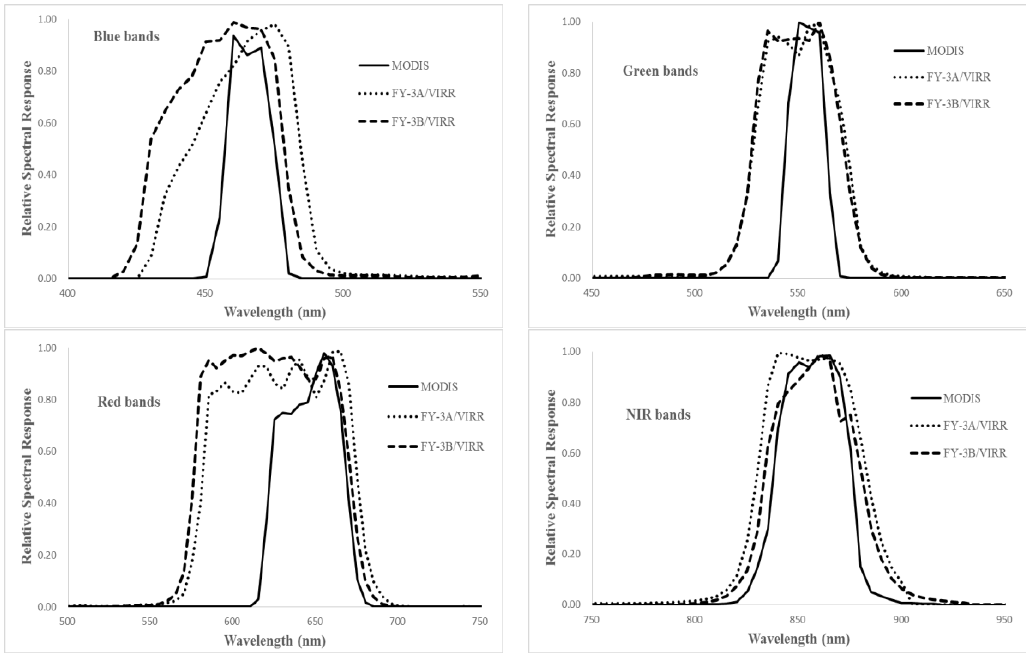
Figure 3. The relative spectral responses of the CCDs and MODIS in VNIR bands.